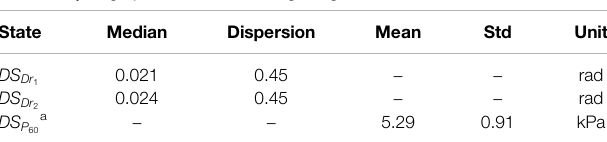
TABLE 1 | Fragility functions for each glazing unit.